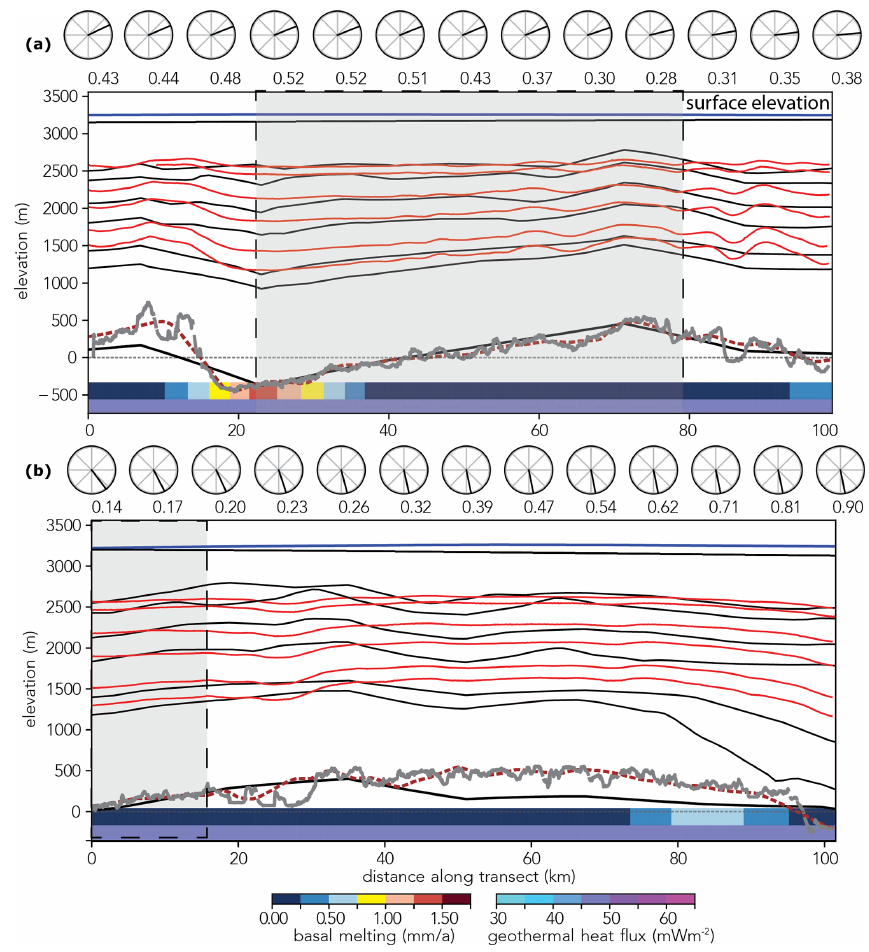
Figure 9. Modelled (black lines) and observed isochrones (red lines 38, 48, 74, 96, 130 and 160ka from top to bottom) for transect DC- X57a (a) and DC-Y77a (b) (orientation from left to right as depicted in Fig. 7a). The vertical grey bars highlight areas with low elevation differences in the low-resolution model bedrock input (black line) compared to the high-resolution radar observations (grey line), which generally correspond to a good match of modelled and observed isochrones. Bedrock and surface elevation in the model runs is plotted in black. Observed surface elevation is plotted in dark blue. The 1km BedMachine data (Morlighem et al., 2020) are depicted by the dashed red line. The labelled circles denote the surface flow and magnitude in ma − 1 relative to the direction of the transect. The coloured bars on the bottom depict the geothermal heat flux (Shapiro and Ritzwoller, 2004) and the computed basal melt rate along the